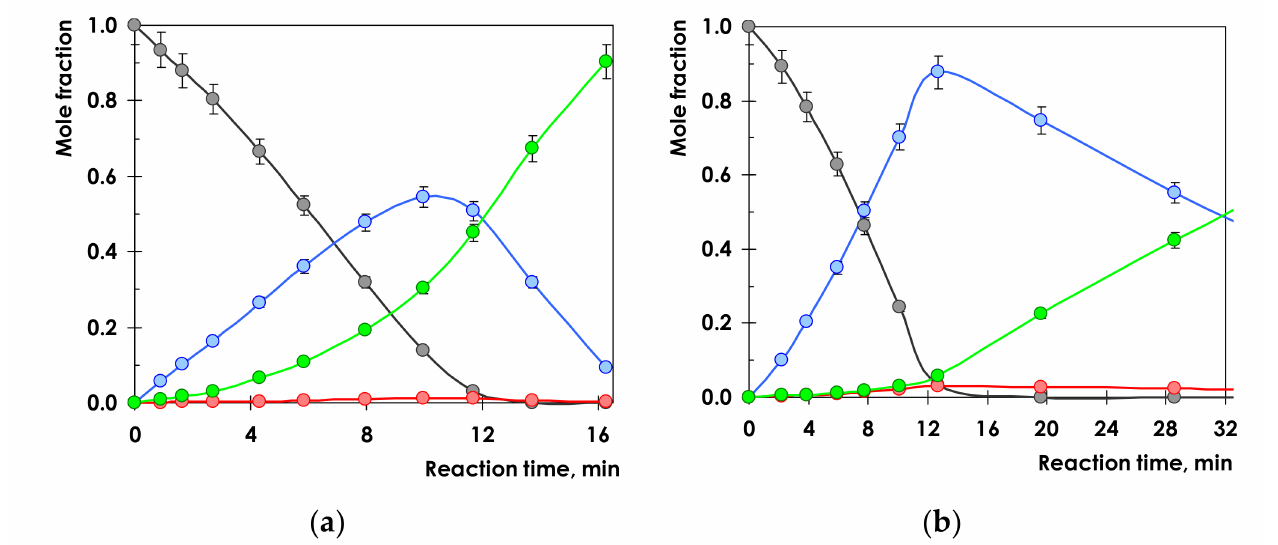
Figure 6. Product distribution for Pd/Al 2 O 3 ( a ) and Pd 1 Ag 3 /Al 2 O 3 ( b ) catalysts. Conditions: T = 25 ◦ C, P(H 2 ) = 5 bar, m(Pd) = 1.5 mg, m(Pd 1 Ag 3 ) = 7.5 mg, V C6H14 = 6 mL. The error bars are ± 1 standard deviation. Black circles—1-phenyl-1-propyne, blue circles—cis-propenylbenzene, red circles—trans—propenylbenzene; green circles—propylbenzene. Propenylbenzenes and propylbenzene are among the only products detected.